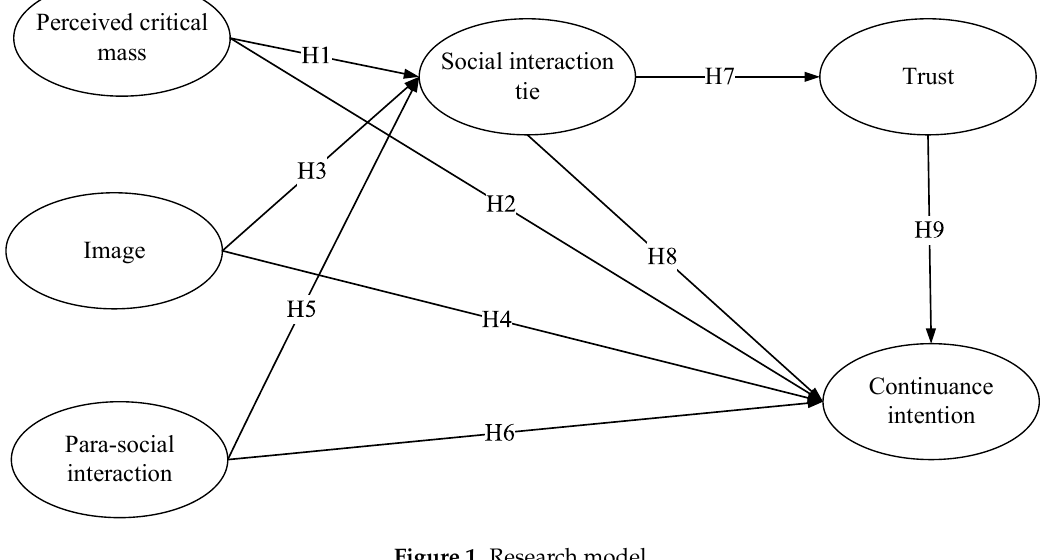
Figure 1. Research model.